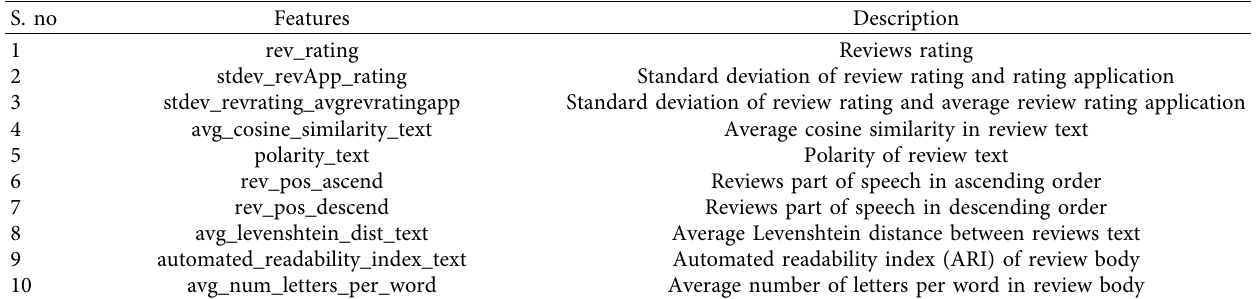
Table 5: Ten best features selected by Information Gain for Yelp Dataset.